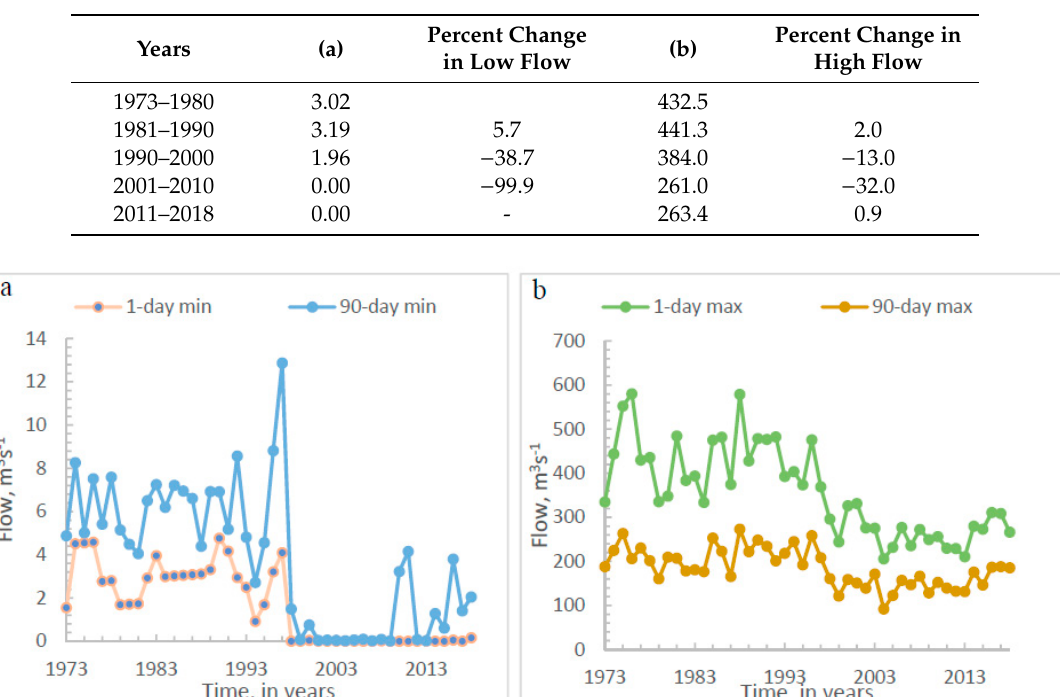
Table 3. Mean decadal (a) low- and (b) high-flows (m 3 s − 1 ) and decadal percentage changes of Gumara River at the ‘outlet’. The mean decadal low flow showed a decreasing trend since 1973–1980 and reached nearly zero for 2001–2010 and 2011–2018.